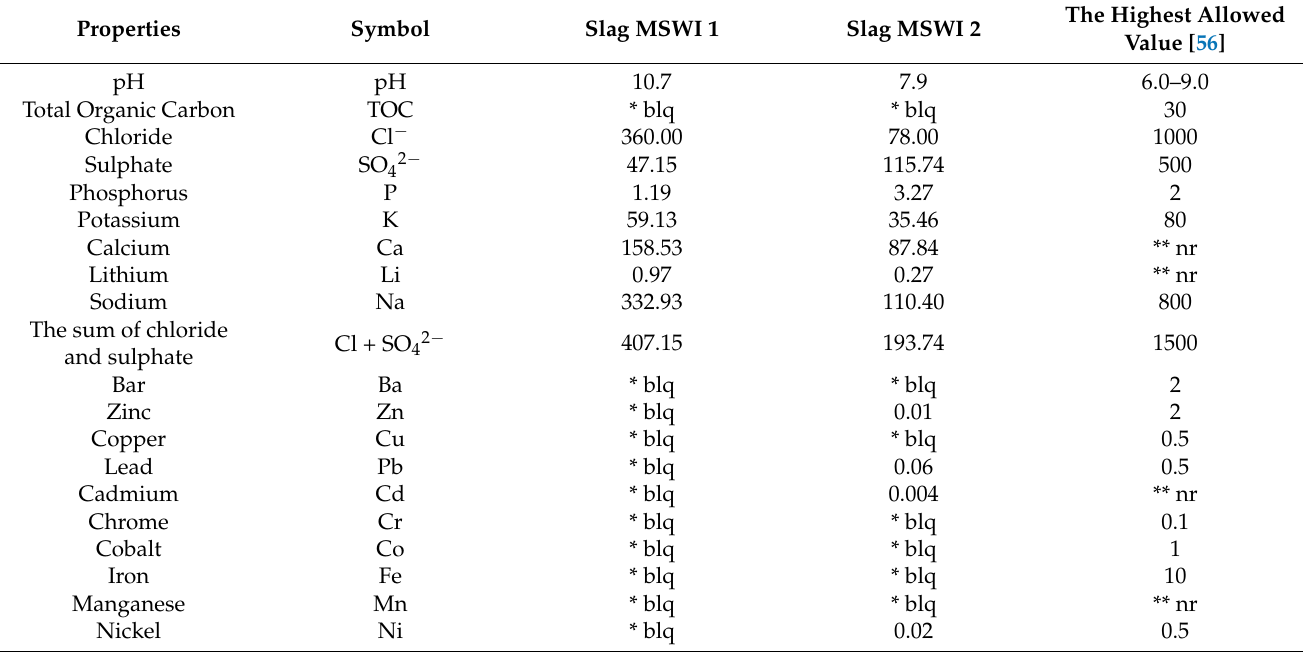
Table 6. Leachability of selected contaminants of tested slags, expressed in mg/dm 3 (with pH exception).